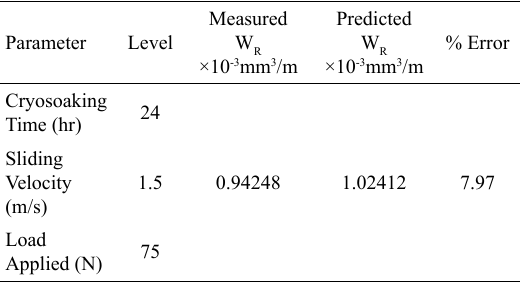
Table 8. Confirmation test